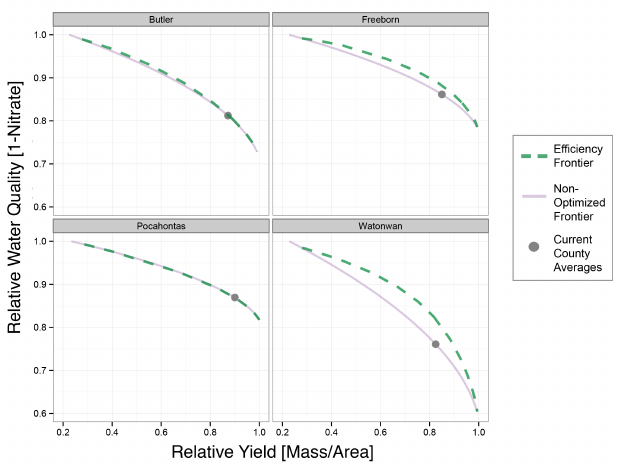
Fig. 3 . Efficiency frontiers and nonoptimized frontiers of Butler and Pocahontas Counties illustrate counties within the study area that fall on the calculated efficiency frontier. Freeborn County illustrates a moderate potential for improvement through optimizing N rates, and Watonwan County illustrates a county with high potential for improvement through optimizing N